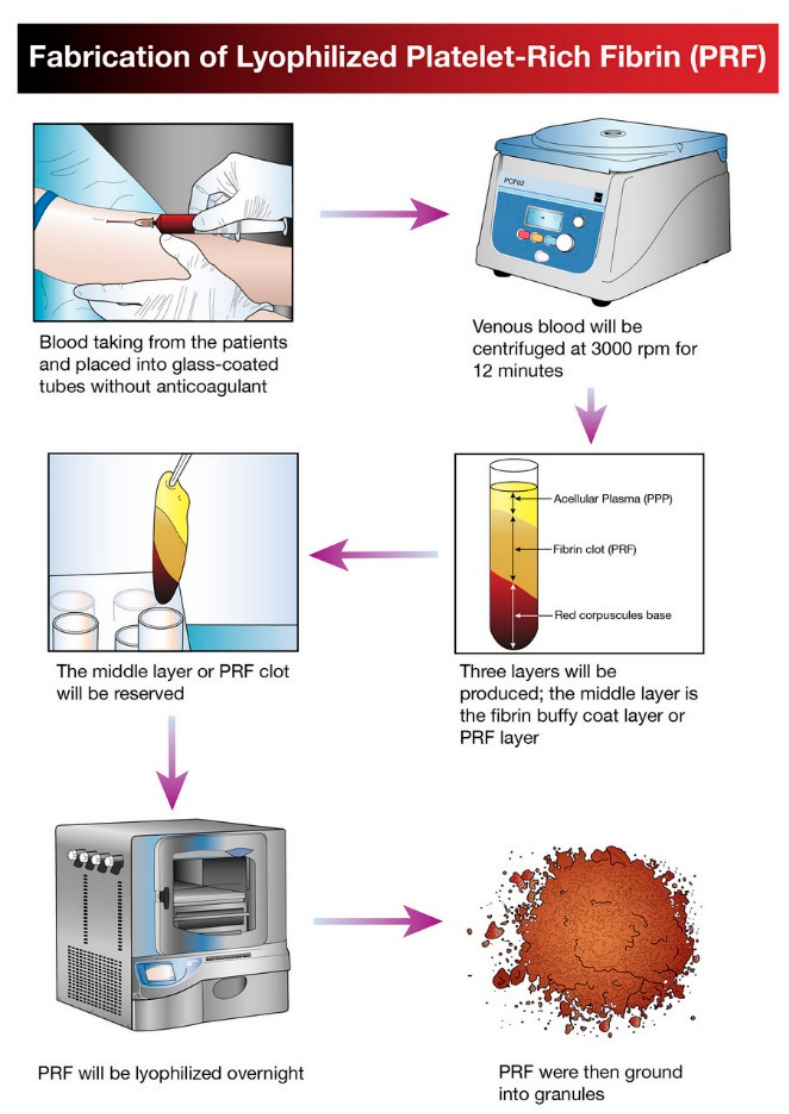
Figure 1. Schematic diagram illustrating the processing and development of lyophilized platelet concentrate (LPC) in the form of platelet ‐ rich fibrin (PRF).